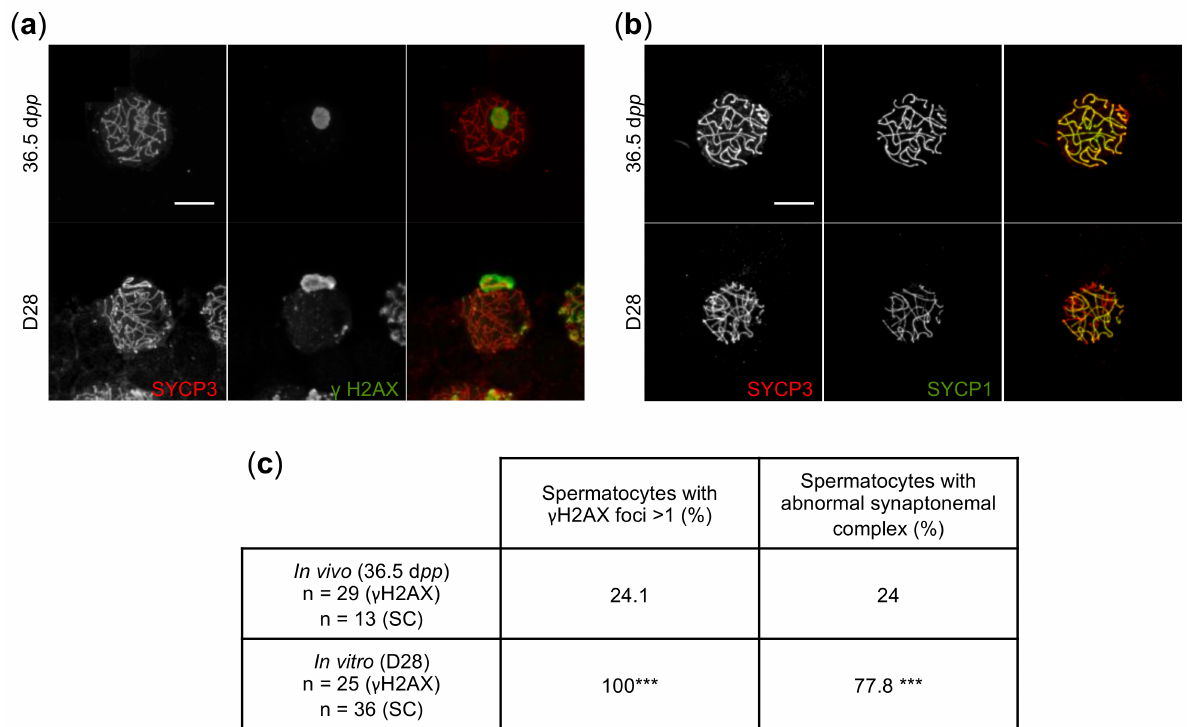
Figure 2. Immunofluorescence staining of meiotic spread preparations from D28 cultured tissues and 36.5 dpp controls. ( a , b ) γ H2AX ( a ), SYCP1 ( b ), and SYCP3 ( a , b ) immunostaining. The upper and lower rows show a representative pachytene spermatocyte at 36.5 dpp and at D28, respectively. Scale bar: 10 µ m, Magnification: × 630, Zoom 4. ( c ) Average percentage of spermatocytes with more than one γ H2AX foci and with abnormal synaptonemal complex at 36.5 dpp (in vivo controls) and at